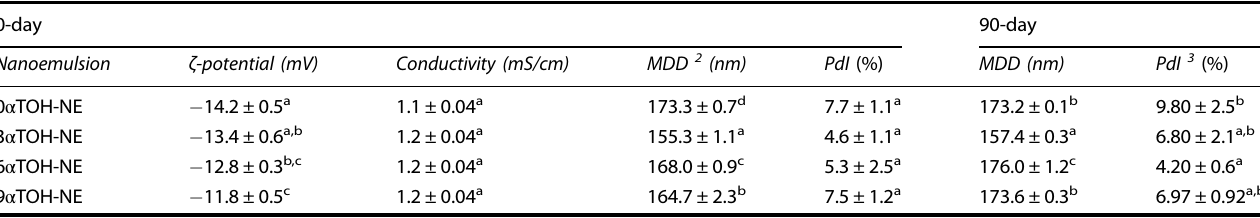
Table 2. Nanoemulsions prepared using different α -terpineol: soybean oil ratios as 10-wt% an oil phase and its values 1 for different parameters: ζ -potential, conductivity, and particle size characterization for 0 and 90-days. 0-day